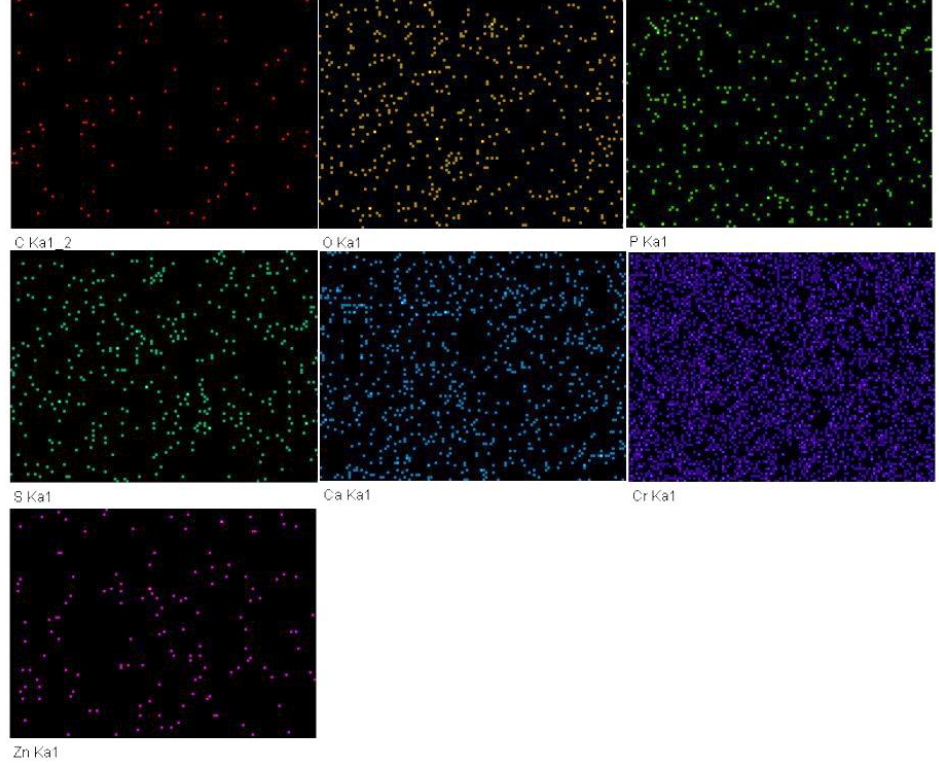
Figure 13. Elemental distribution mapping on the worn surface of Figure 12b.